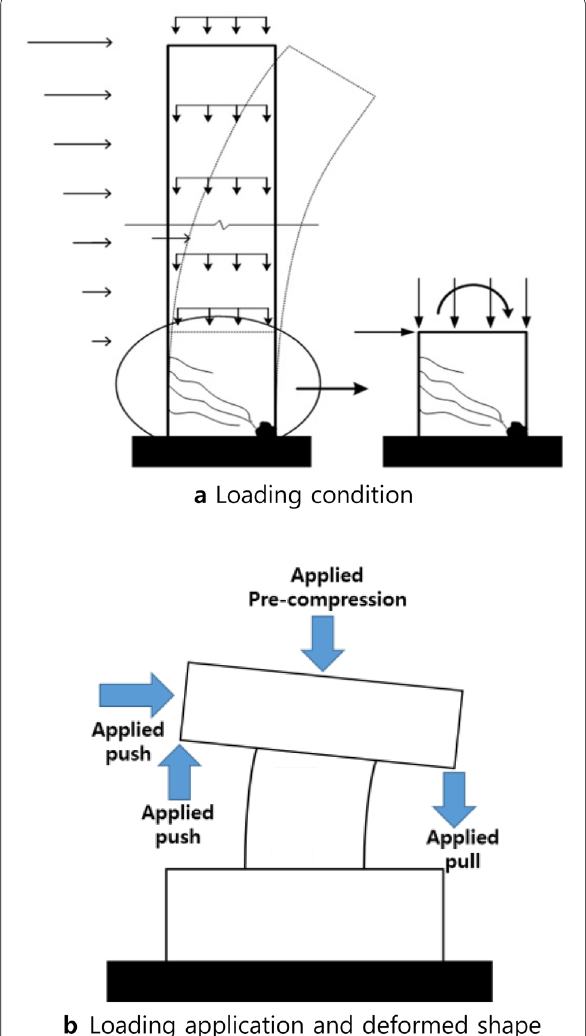
Fig. 1 Loading condition of slender